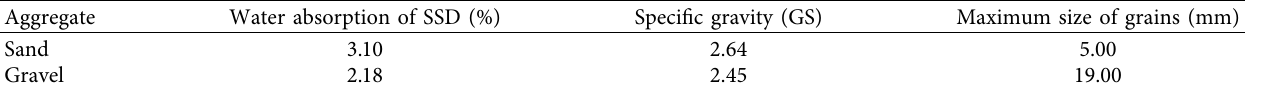
Figure 1: Particle size distributions of aggregates [25]. Table 1: Properties of aggregates.